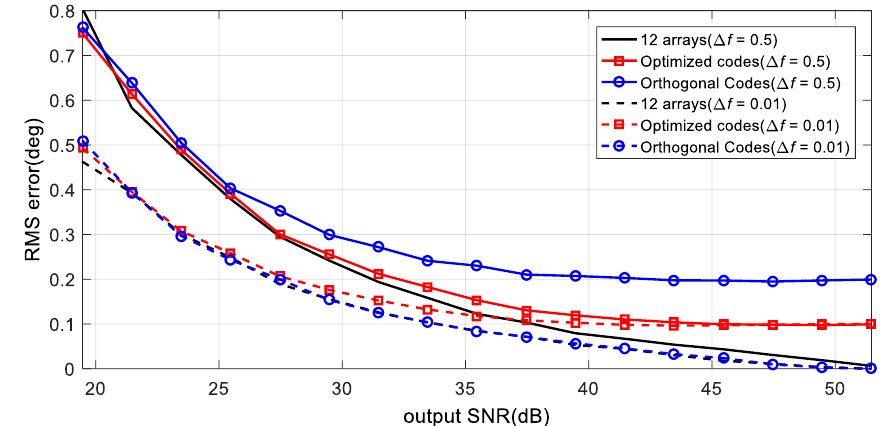
Figure 10. Comparison of RMS errors according to SNR.